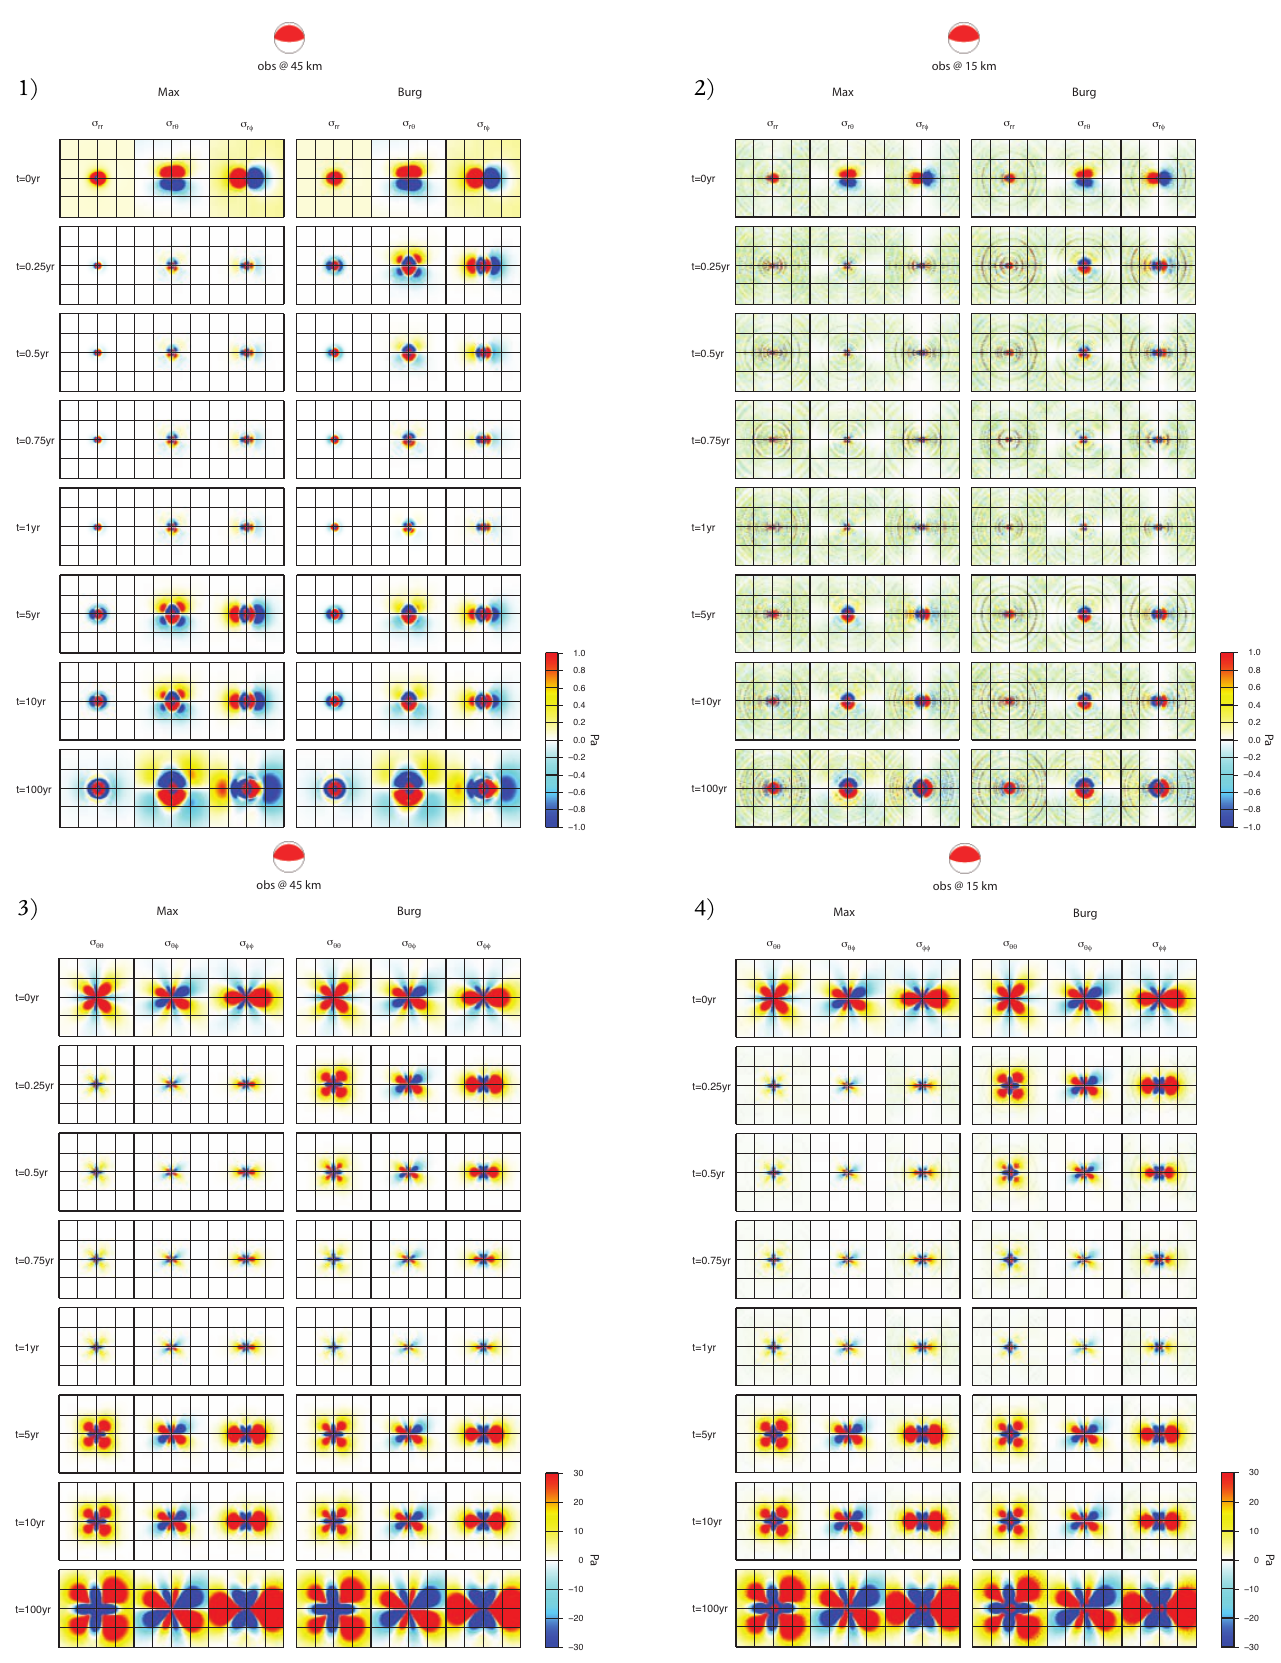
, v , v ) evaluated for a point-like, dip-slip fault buried at 30 km, according to the rr r i r z = 10 21 Nm, and its strike direction is towards the North. The observer is 0 , v , v ) and for an ii iz zz , v , v ) and for an observer located at 15 km in ii iz zz